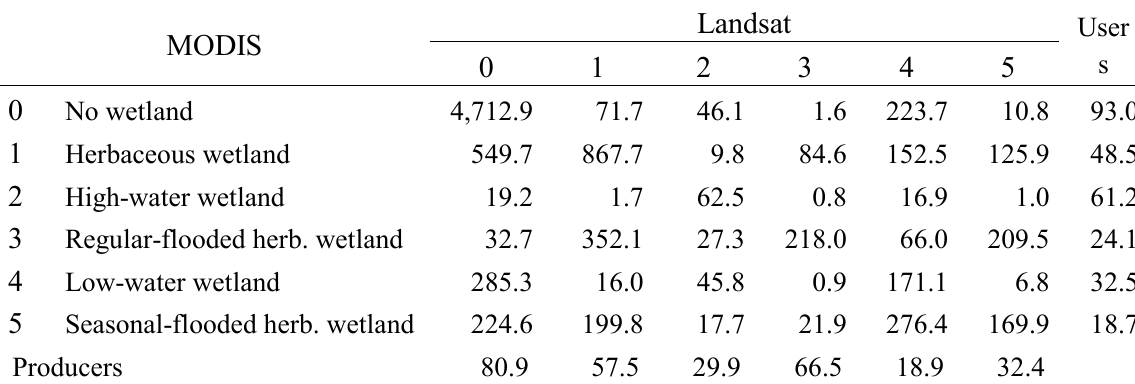
Table 2. Error matrix for the inland Niger Delta site showing all five wetland classes mapped from MODIS and reference classes from Landsat. Cell values indicate the area-agreement of Landsat and MODIS in km 2 . The users and producers accuracies are shown for all classes.